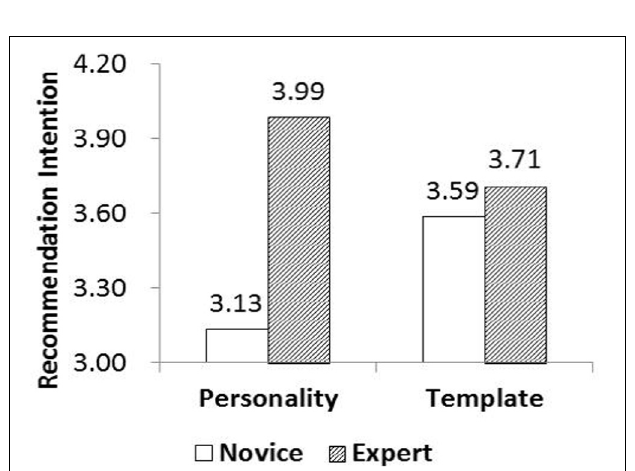
FIGURE 5 | Interaction between customer knowledge and materials